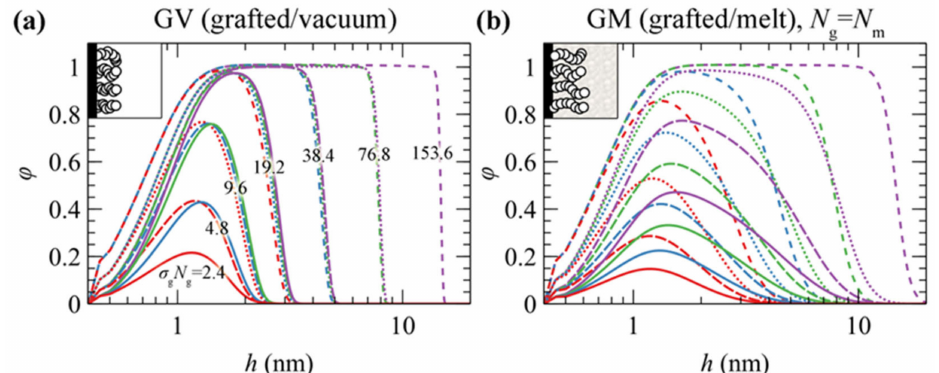
Figure 3. Reduced density profiles of polystyrene PS brushes from SL-SGT EoS in the absence of the ramp potential in ( a ) grafted/vacuum (GV) and ( b ) grafted/melt (GM) systems for N g = 24 (red), 48 (blue), 96 (green) and 192 (violet), and σ g = 0.1 (solid lines), 0.2 (dashes), 0.4 (dots) and 0.8 (short dashes) nm –2 . The numbers in ( a ) depict the value of the product σ g N g in nm –2